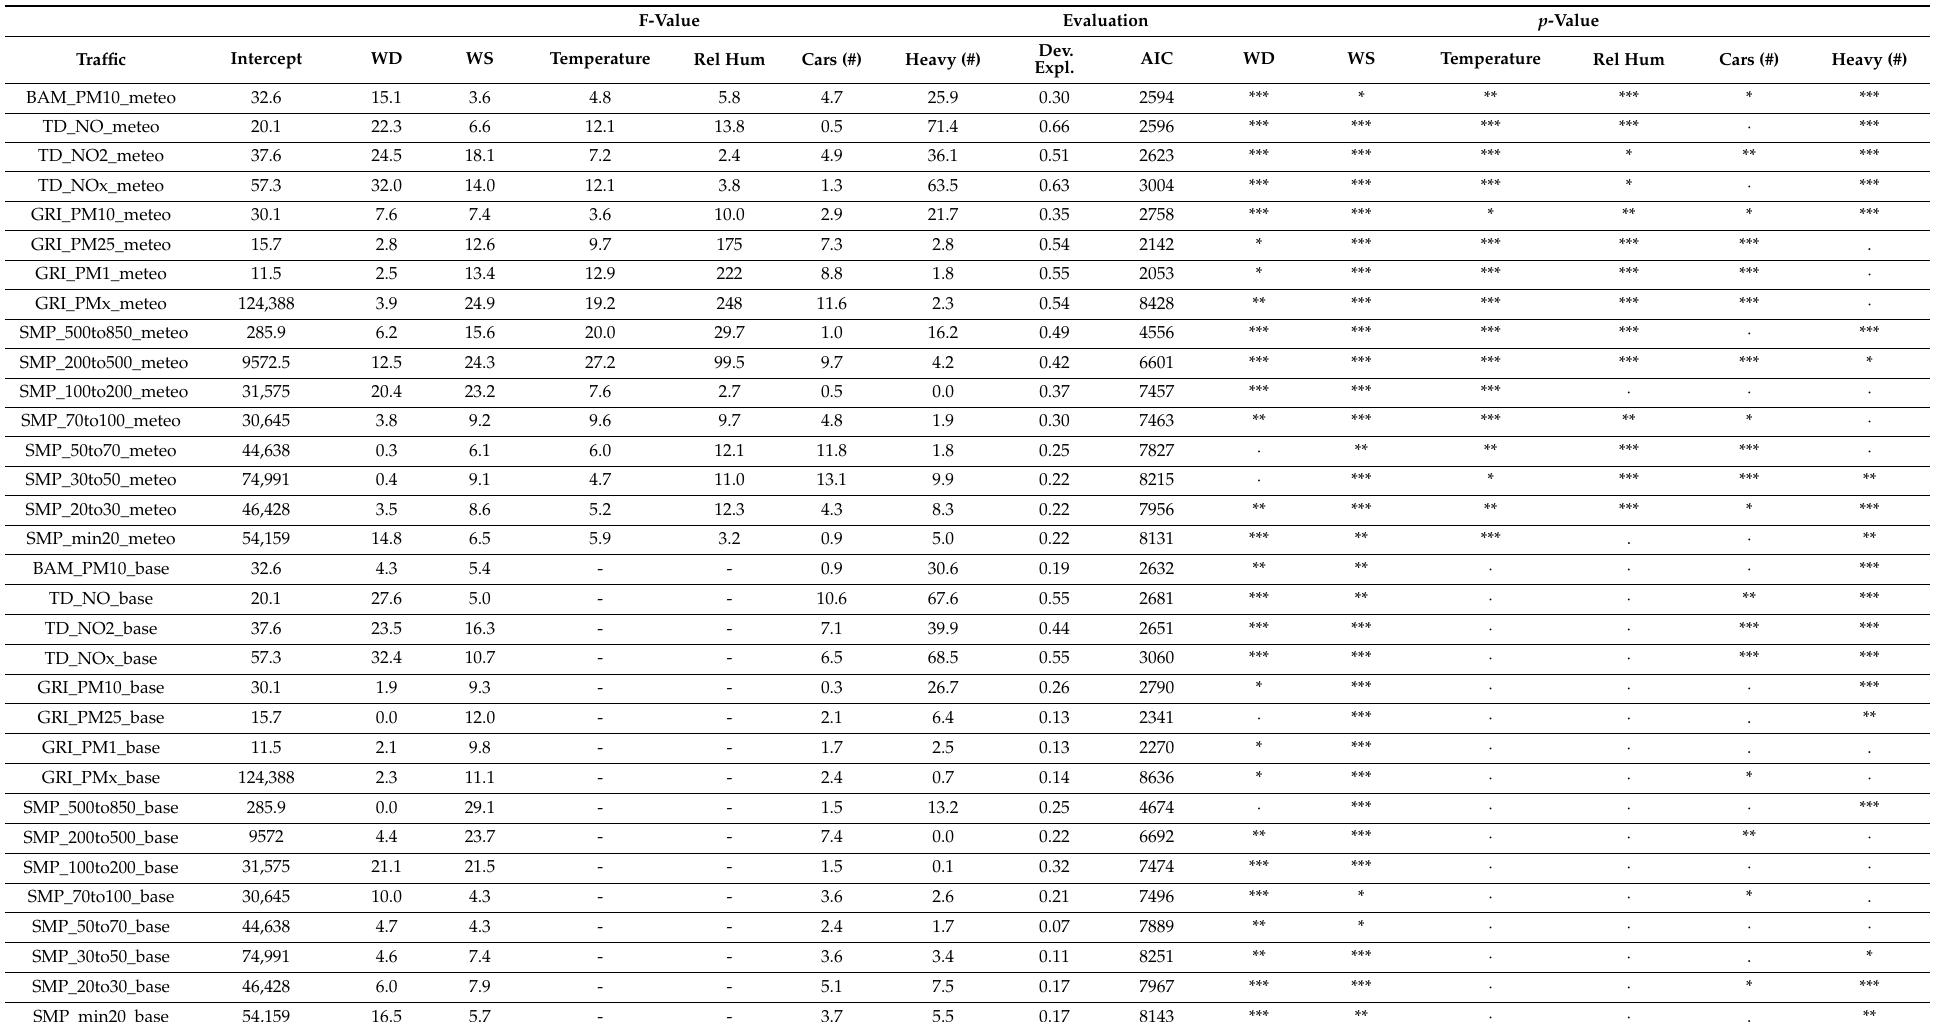
Table 2. Summary of the GAM models for the noise parameters: L Aeq and OLF, with and without temperature and relative